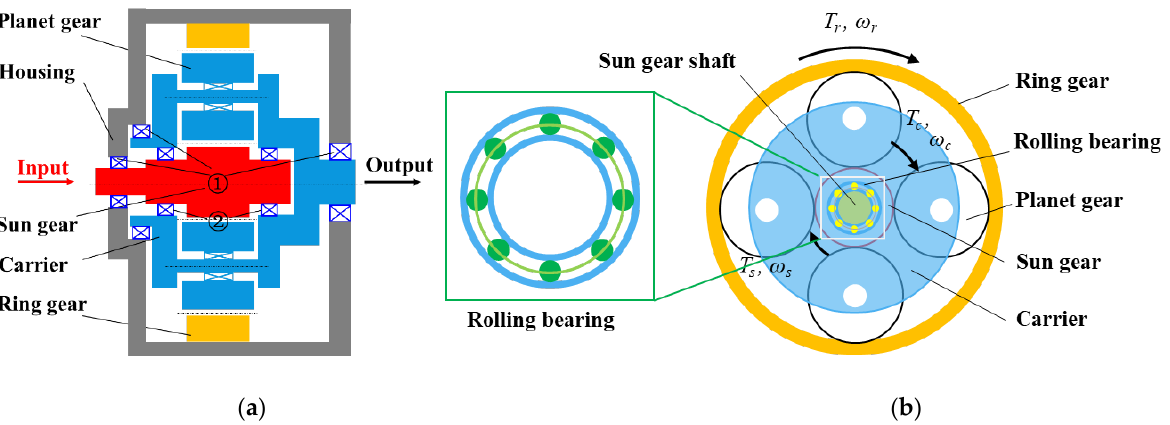
Figure 1. PGS coupled with a dual-rotor subsystem: ( a ) schematic diagram; ( b ) a simple dual-rotor system supported by rolling ball bearings .